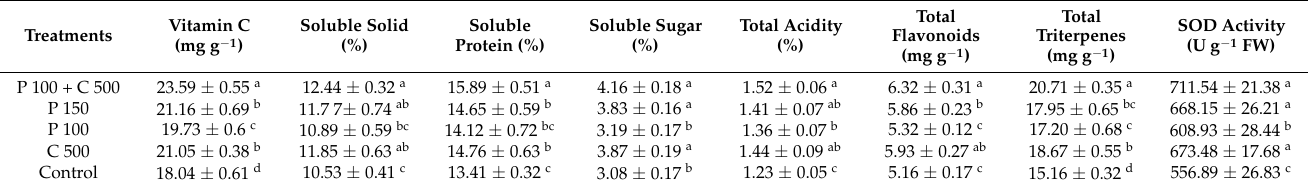
Table 3. The influence of pyraclostrobin and chitosan on R. roxburghii quality.